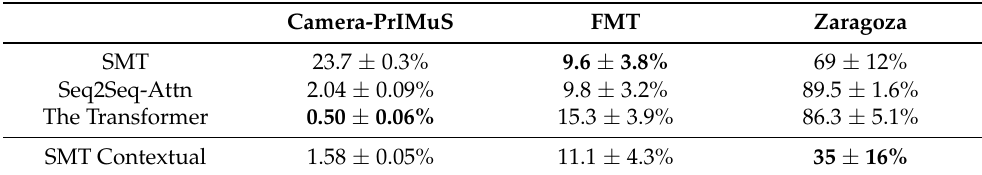
Table 3. Results obtained in terms of average SER and standard deviation on the 10-fold cross- validation samples for the three corpora used for evaluation. Results for the three approaches evaluated on the task of translating standard agnostic input into **kern ∗ are reported. Additional results are presented in the last row using SMT to translate contextual agnostic input into **kern ∗